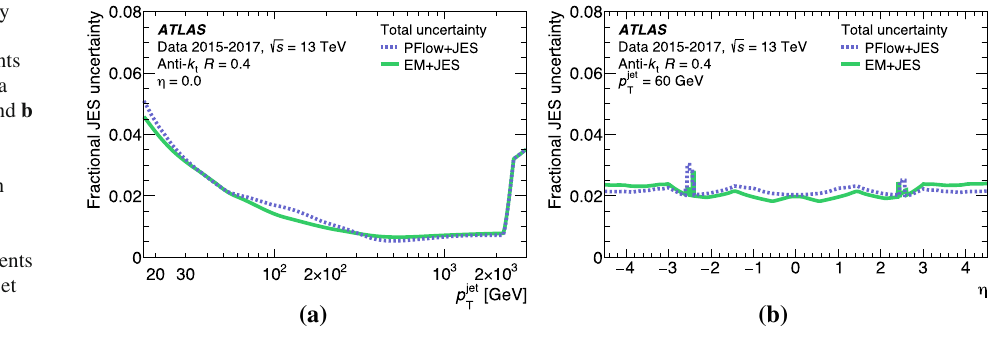
Fig. 24 Fractional jet energy scale systematic uncertainty summed across all components for anti- k t R = 0 . 4 jets a as a function of jet p T at η = 0 and b as a function of η at p T = 60 GeV. The total uncertainty is shown for both EMtopo and PFlow jets. Contributions